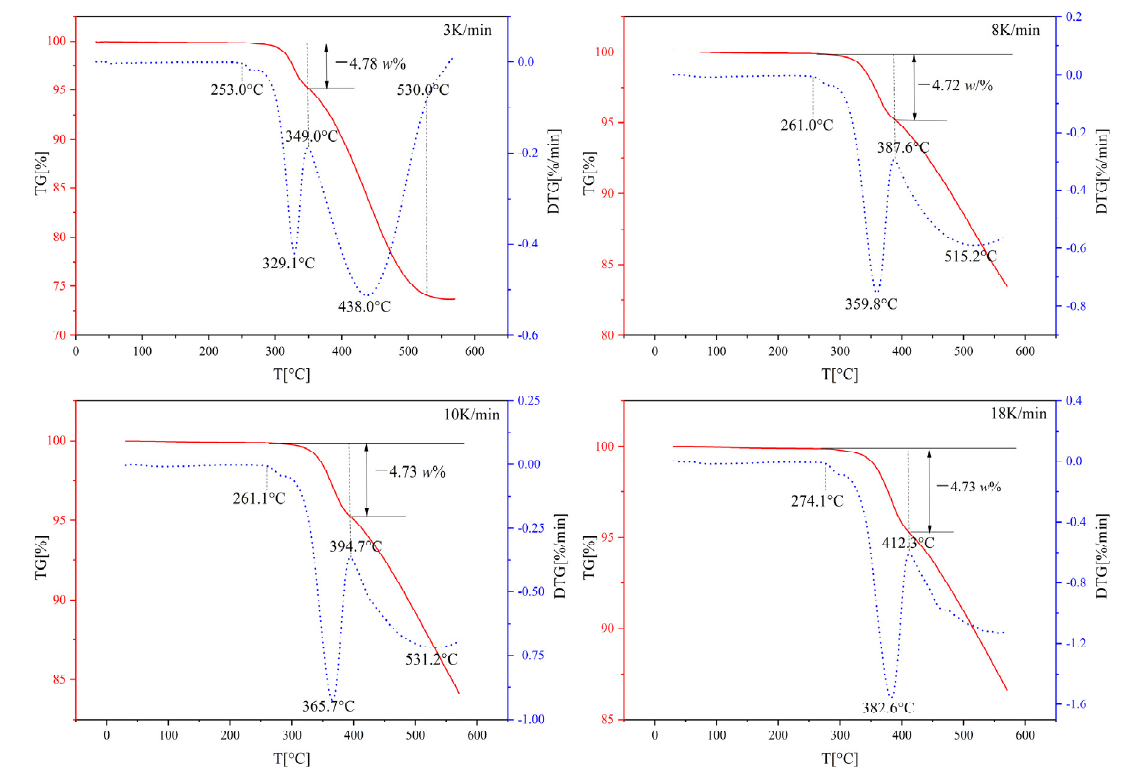
Figure 3. TG curves and DTG curves of experimental data. Red: TG curve. Blue: DTG curve. Table 2. The selected temperature ranges of the two reactions.